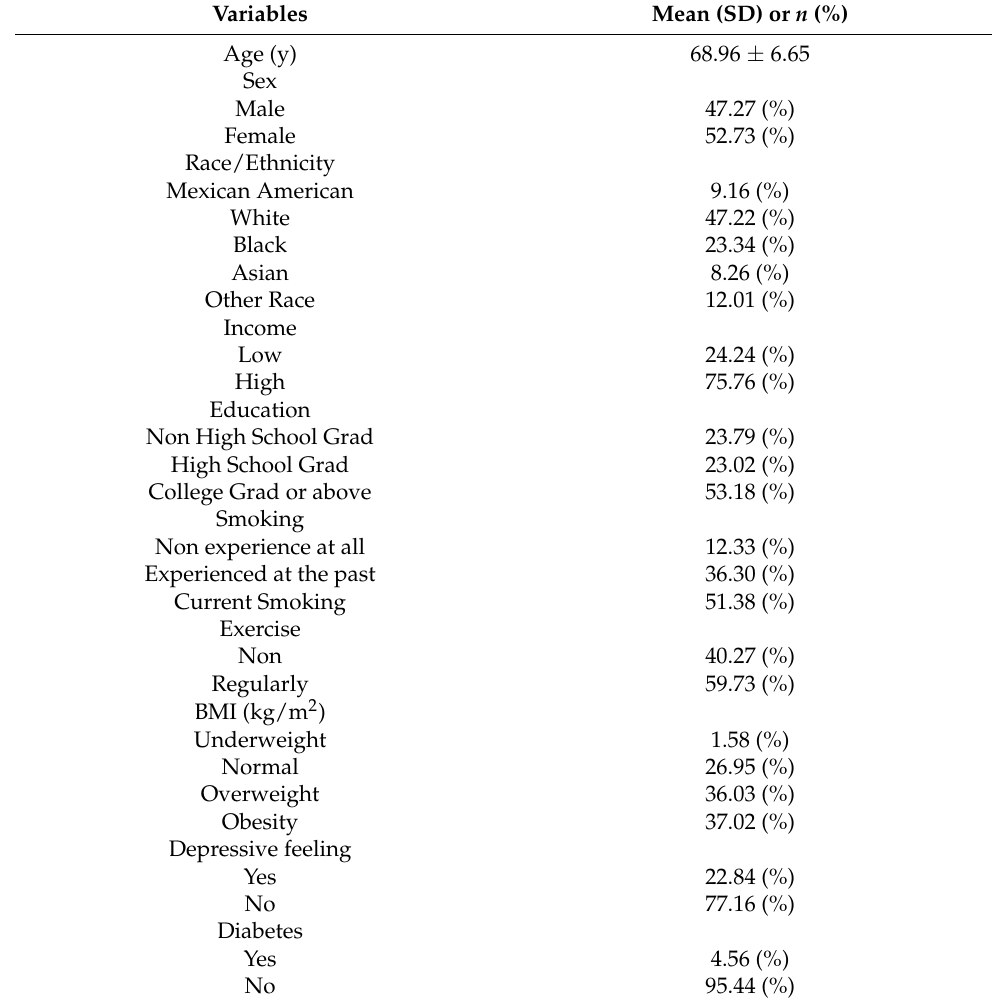
Table 1. Characteristics of the study population ( n =